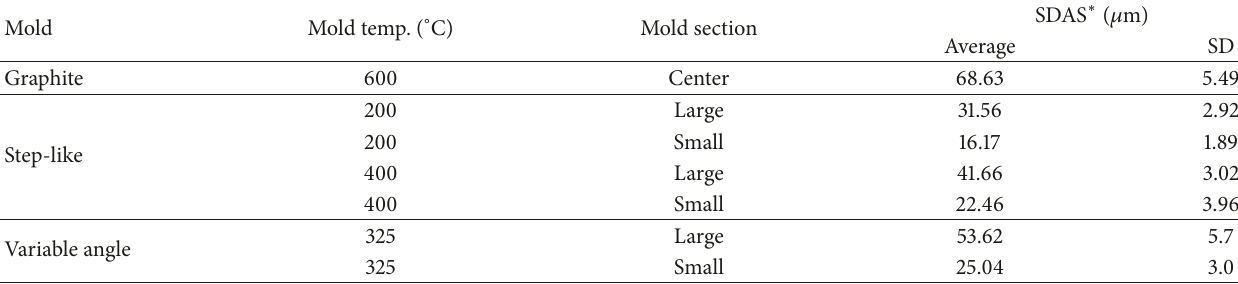
Table 3: Average secondary dendrite arm spacing of the examined A356 alloy samples.